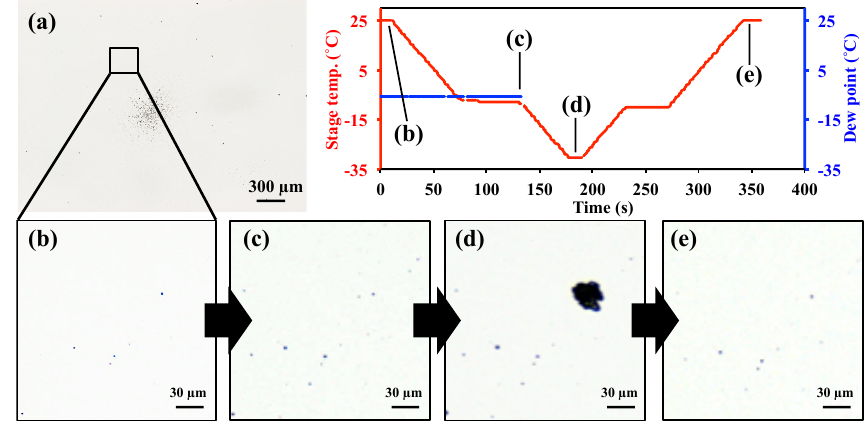
Figure 1. Optical images of sample particles deposited on Si (silicon) wafer substrate before the freezing experiment (a, b) , after exposure to water supersaturation conditions at − 9 ◦ C (c) , after cooling to − 30 ◦ C (d) , and after sublimation and evaporation by dry air (e) . The inset graph shows the stage temperature and the dew point of the wet air introduced into the cell before exposing the stage to water supersaturation.